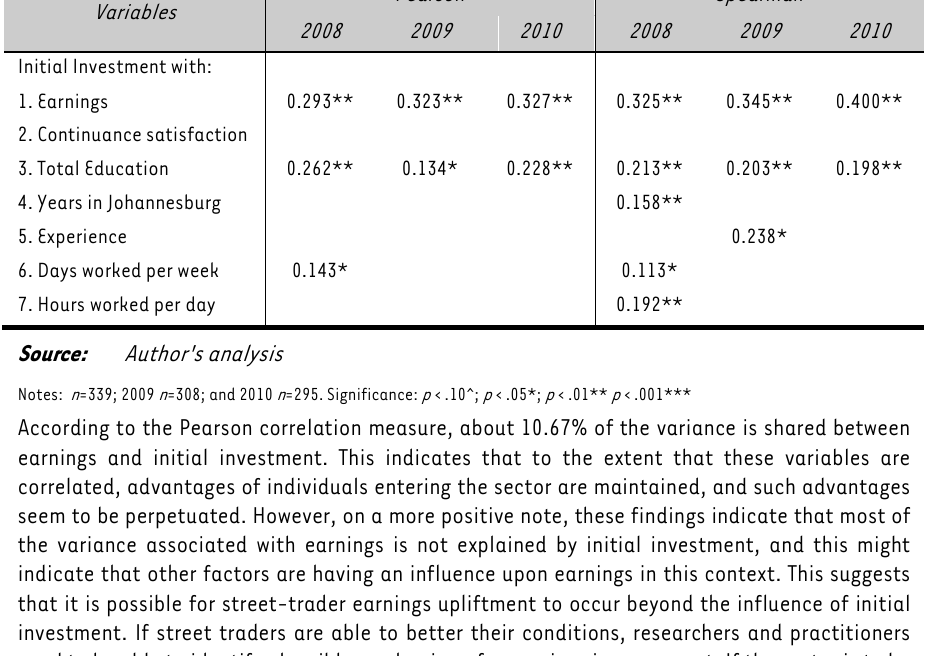
Pearson and Spearman coefficients of correlations for 2008, 2009 and 2010 Pearson Spearman Variables